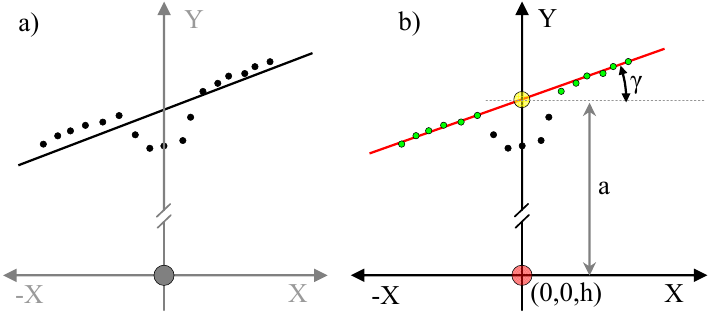
Figure 10. Representation of the procedure used to estimate the frontal line: (a) line obtained with all scan points, (b) final line obtained with the outliers removed.